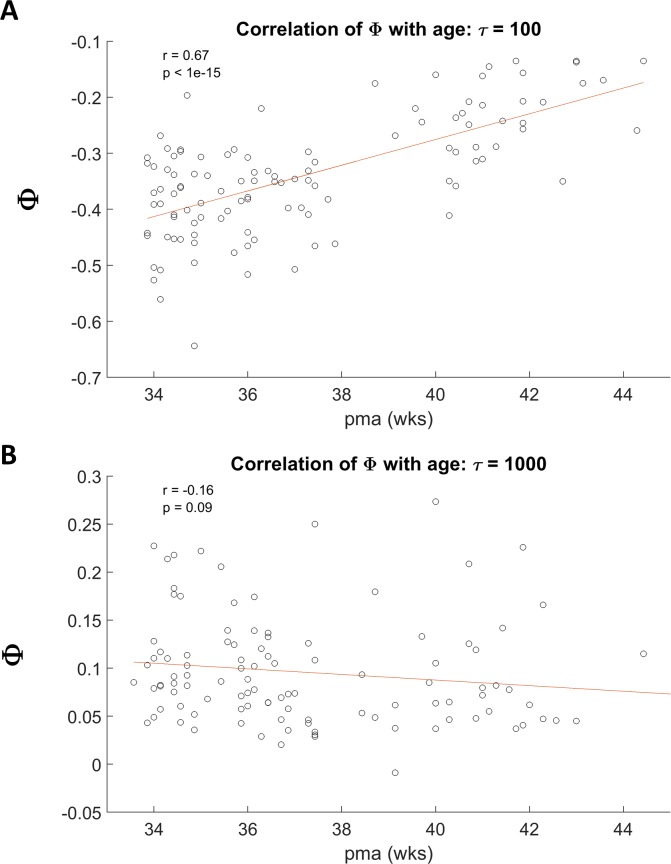
Correlation of Φ with age.Two examples of mean correlations of Φ with postmenstrual age (pma), one for τ equal to 100 ms (A) and the other for τ equal to 1000 ms (B). In A, the correlation coefficient was 0.67 (p < 10−14) while in B no correlation was found. Results were pooled across groups (FNI and SC) and sleep states (AS and QS).